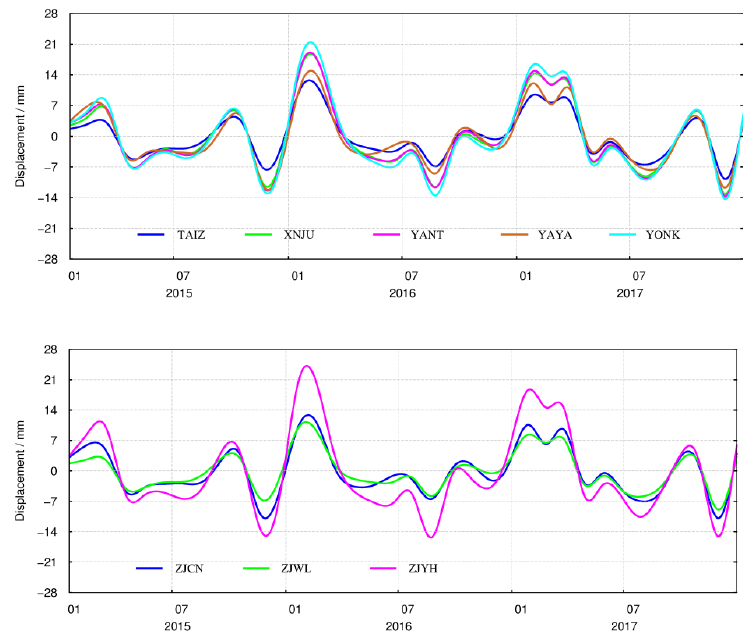
3. Supplement to Figure 8. Figure A2. Supplement to Figure 6.